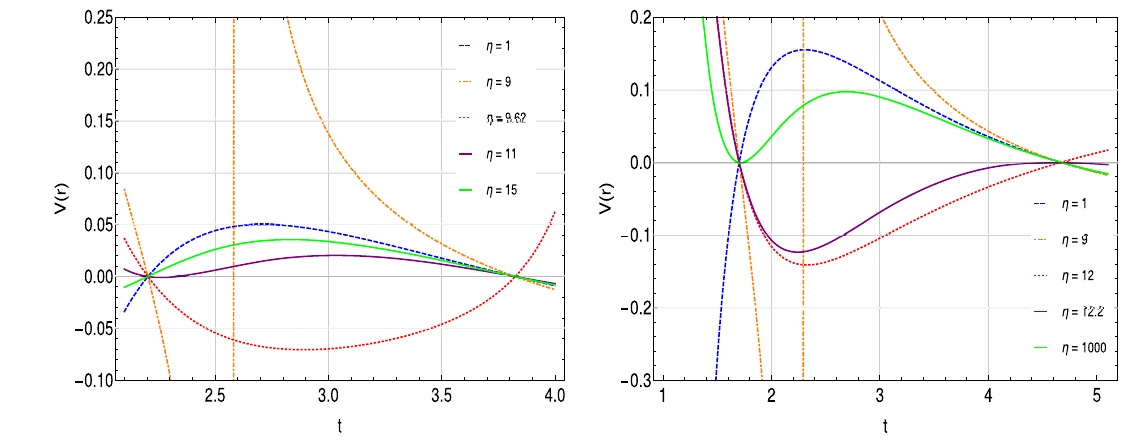
Fig. 3 Potential of the Klein–Gordon field in the RNdS geometry with non-minimally coupling. Left panel: Potential for the regions (i) ( η = 1) to (v) ( η = 15) of Table 2. The horizons are located at